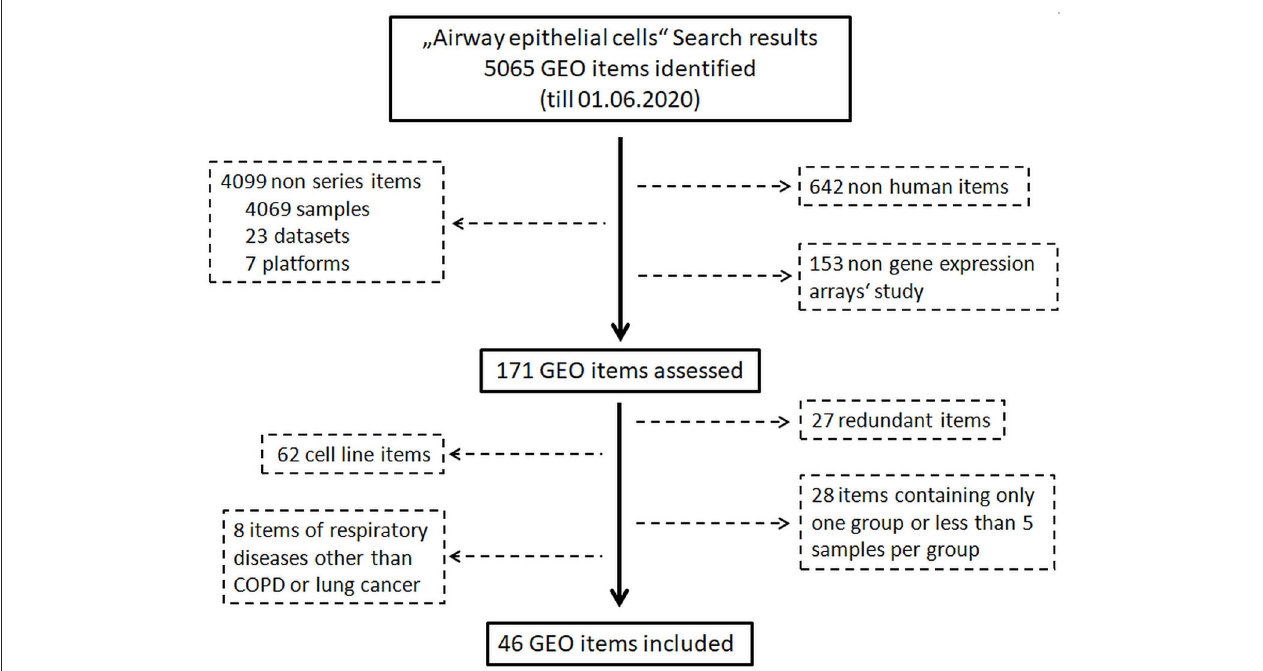
FIGURE 1 | Flow diagram of GEO databases screening and selection